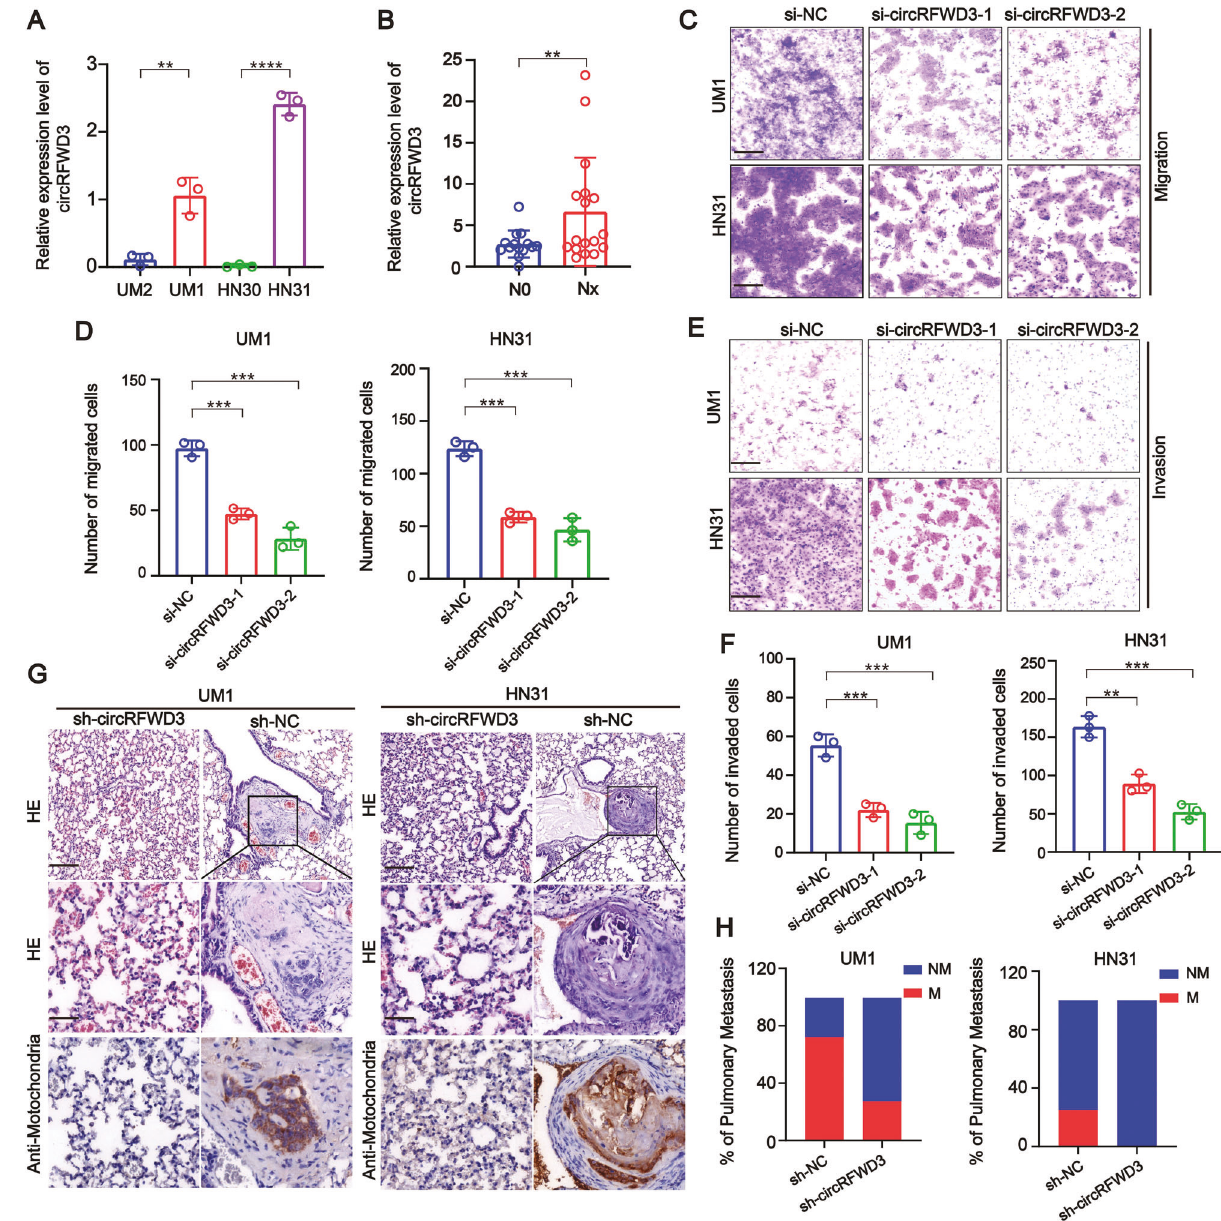
Fig. 2 CircRFWD3 could enhance the migration and invasion ability of HNSCC cells in vitro and in vivo. A qRT-PCR assay showed the expression level of circRFWD3 in different HNSCC cell lines (UM1, UM2, HN30, and HN31). B A clinical cohort of nonmetastatic and metastatic HNSCC patient samples indicated signi fi cantly high expression of circRFWD3 in metastatic HNSCC patients (N0 = no lymph node metastasis, n = 15; Nx lymph node metastasis, n = 15). C , D The migration ability of UM1 and HN31 cells with silenced circRFWD3 was examined by transwell assays, scale bar, 100 μ m. E , F The invasion ability of UM1 and HN31 cells by silencing circRFWD3 was examined by transwell assays, scale bar, 100 μ m. G H&E and IHC analysis determined the metastatic tumor nodules in the lungs of mice injected with sh-NC or sh-circRFWD3 stably transfected UM1 and HN31 cells, scale bar, upper 100 μ m, middle 10 μ m. H Statistical graphs showed that the metastatic rate of the UM1 sh-NC group was 72.3% ( n = 11), UM1 sh-cirCRFWD3 group was 27.3% ( n = 11), HN31 sh-NC group was 25% ( n = 12), and HN31 sh-cirCRFWD3 group was 0% ( n = 12). NM no pulmonary metastasis, M pulmonary metastasis; Scale bar, 100 μ m. Data were shown as the mean value ± SD of three independent experiments. The asterisks indicate signi fi cant differences (Student ’ s t -tests, * P < 0.05, ** P < 0.01, *** P <